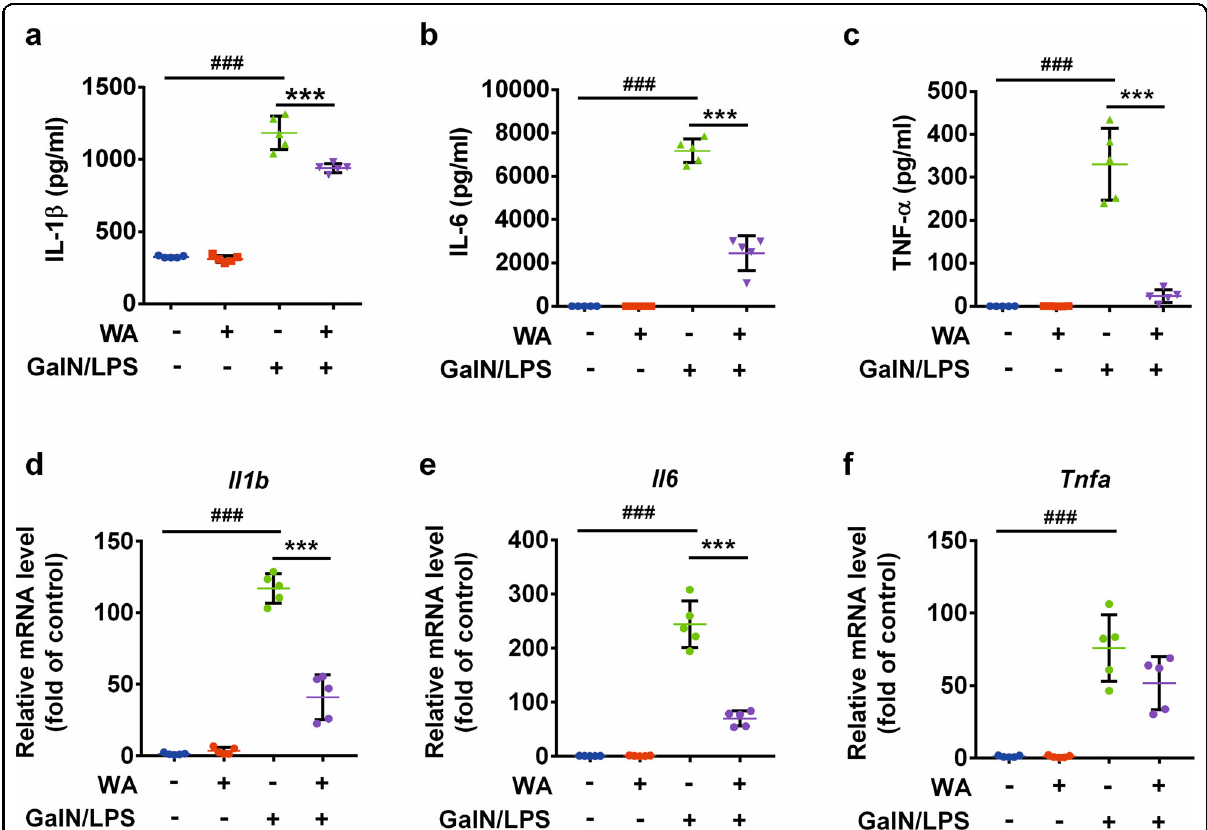
Fig. 2 WA suppressed GalN/LPS-induced in fl ammatory response. Serum IL-1 β levels ( a ), Serum IL-6 levels ( b ), and Serum TNF- α levels ( c ). mRNA levels of hepatic Il1b ( d ) , Il6 ( e ), and Tnfa ( f ). Data are presented as means ± SD ( n = 5 unless otherwise indicated). Groups were same as described in Fig. 1 legend. One-way ANOVA was used for statistical analyses. ### p < 0.005 versus Control group; ** p < 0.01 and *** p < 0.005 versus V + GalN/ LPS